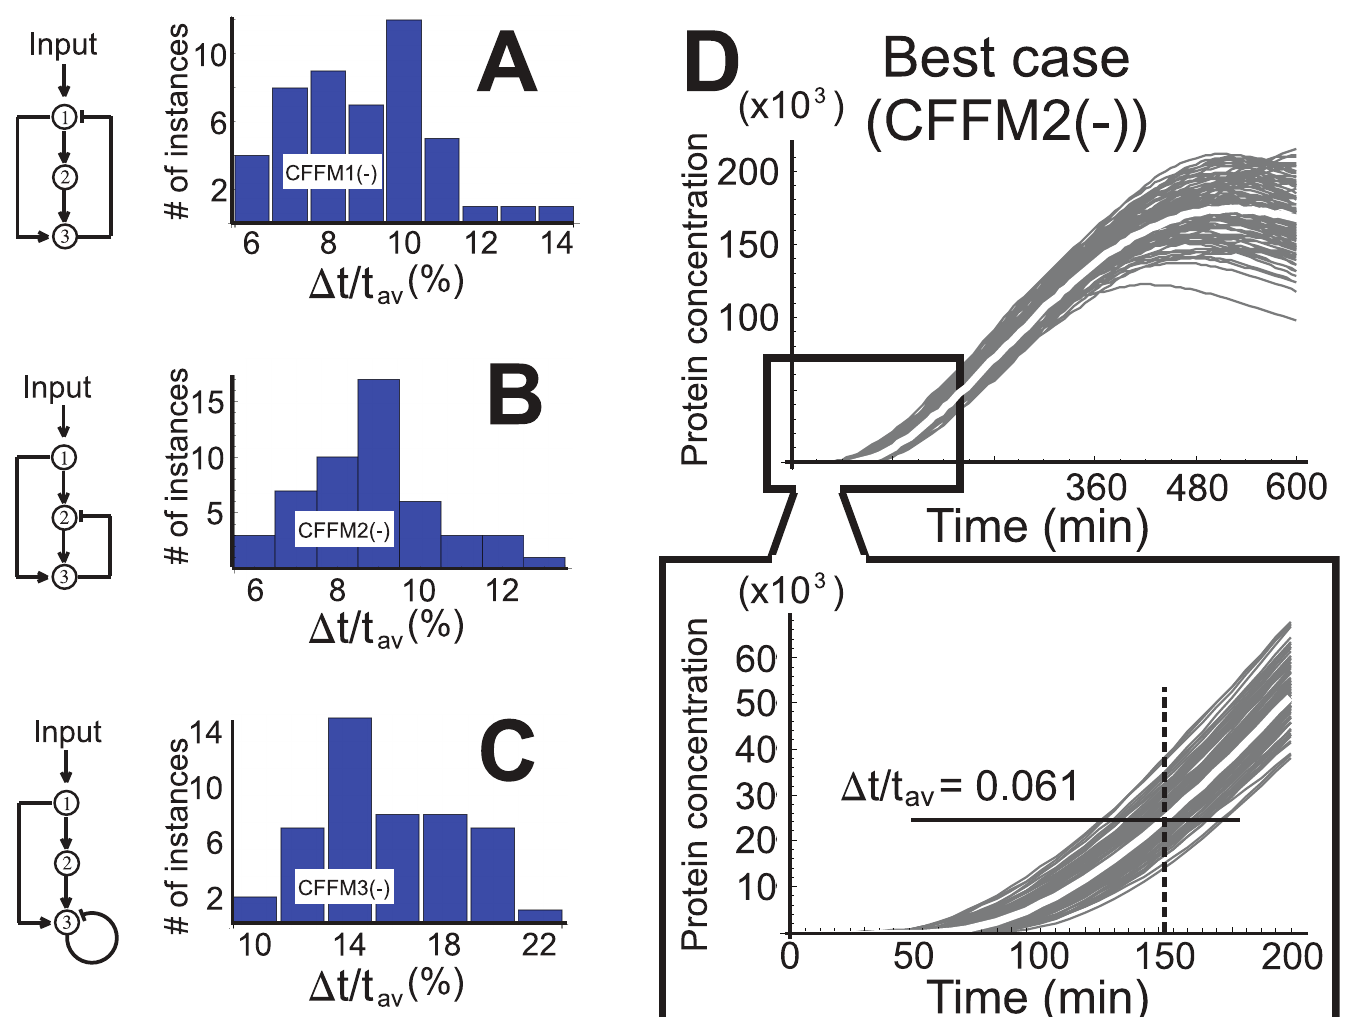
Fig 7. Three variations on the coherent feed-forward motif. The histograms in A, B and C show the distributions for the three variations on the CFFM the schematics of which are to the left. In all three cases, the transcription factors bind to the different promoters one at a time: no (hetero) dimers. D) Best case, corresponding to CFFM2(-) with Δ t / t av =